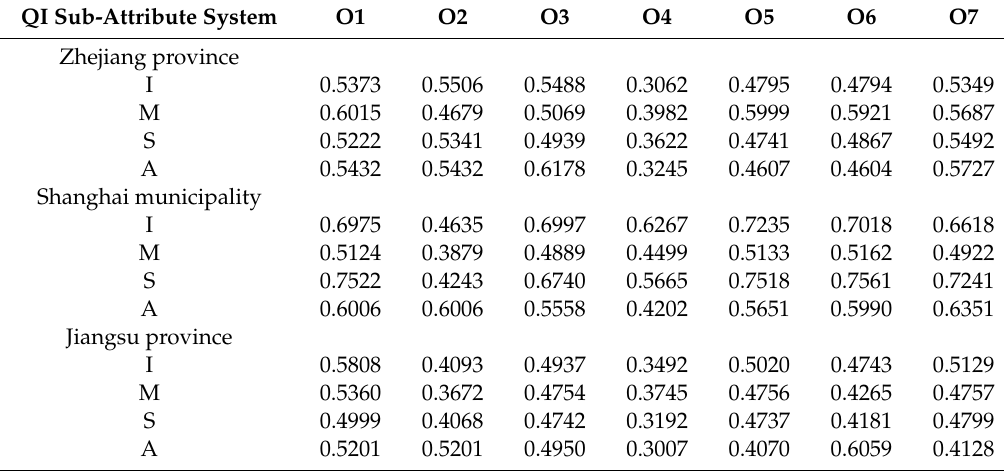
Table 4. The contribution degree the matrix of the QI sub-attribute system to the EEQ sub-object in the YRD